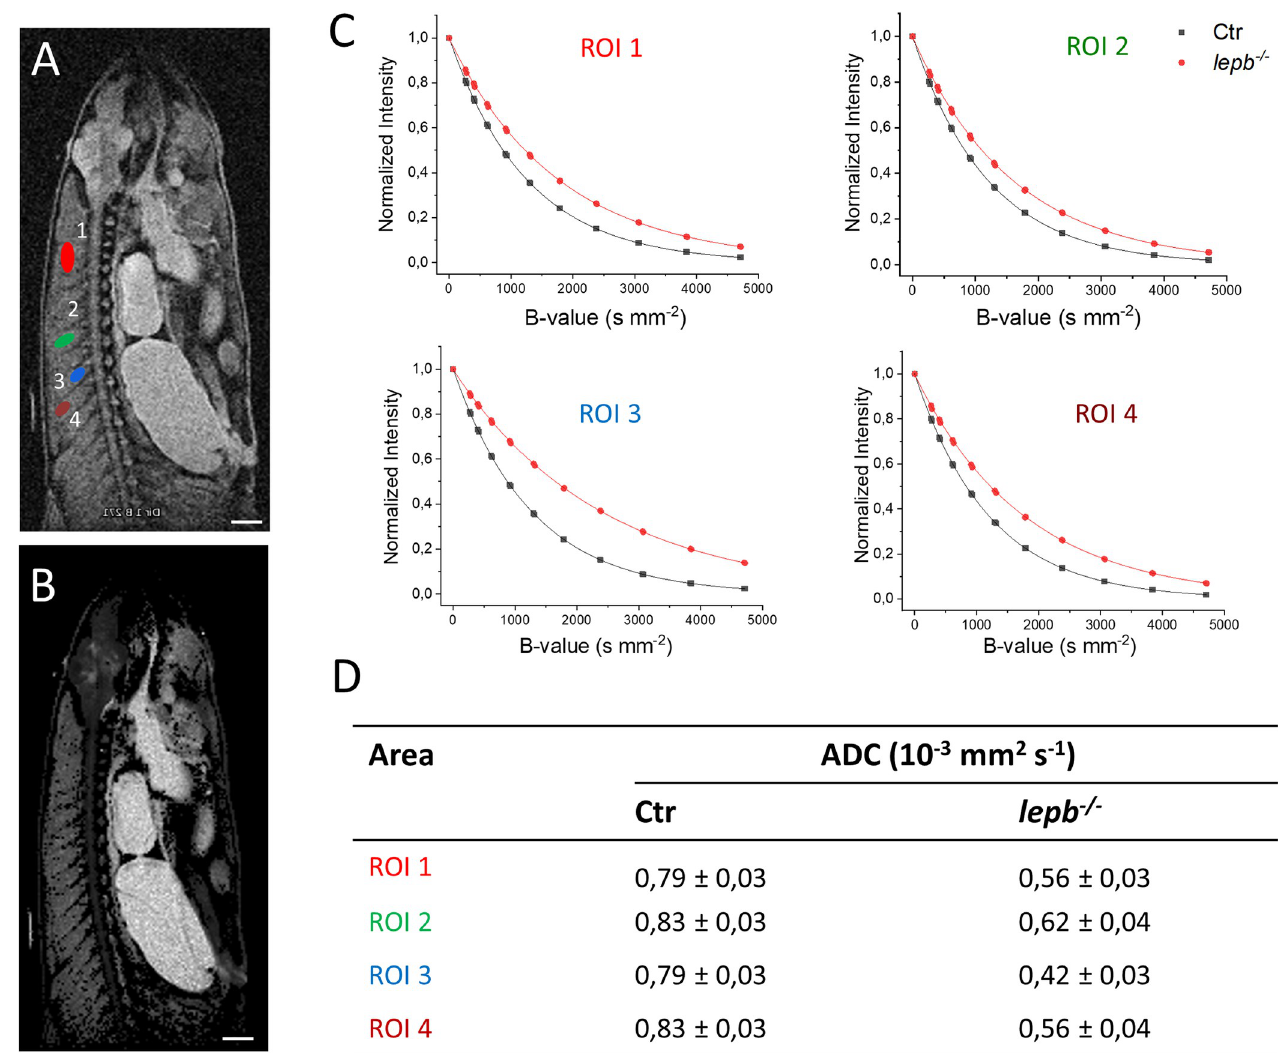
Fig 5. Diffusion-weighted imaging in muscle regions of control (Ctr) and lepb -deficient ( lepb -/- ) adult zebrafish. Diffusion measurements were performed using a spin-echo pulse sequence containing a pair of mono-polar diffusion-sensitising gradients (TR, 1000 ms; TE, 60,2 ms; diffusion gradient duration 4 ms and gradient separation of 50 ms; effective B-values range: 221, 267, 399, 614, 914, 1299, 1792, 2385, 3070, 3846, 4714 s/mm 2 ). (A) A diffusion image of control zebrafish showing regions of interest (ROI) located in various muscle regions of adult zebrafish. The first ROI (red) is located in the middle of the upper myotome. The second one (green) covers the middle part of one of the myotomes. The next one (blue) is a smaller region located in the part of the myotome near the spinal cord. The last region (brown), area 0,15 ± 0,01 mm 2 is located far from spinal cord (closer to skin). (B) Representative ADC map image of Ctr zebrafish generated through Bruker internal ‘ dtraceb ’ algorithm. It shows the distribution of ADC values where higher ADC appears bright and lower ADC appears darker. (C) Signal decay curve in respective ROIs is shown in (A). (D) Table of calculated ADC values for regions of interest is shown in (A). Scale bar: 1